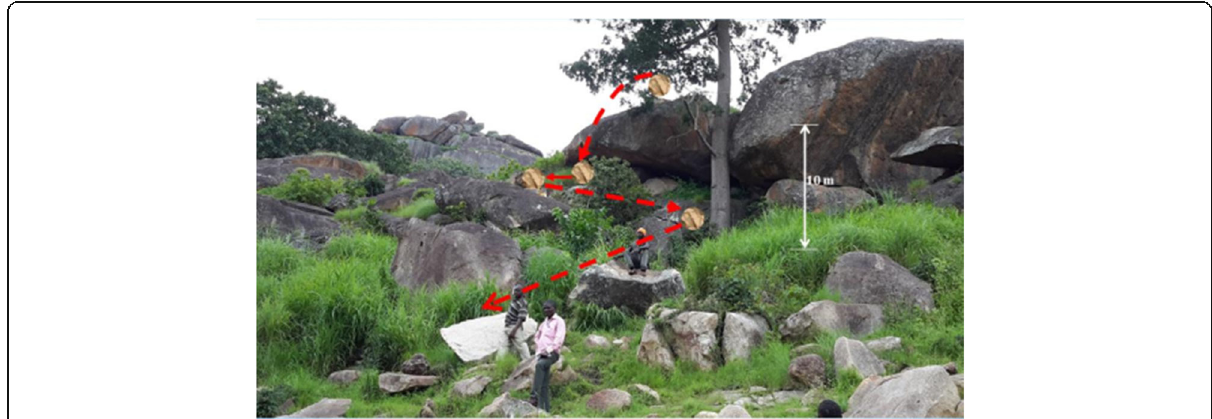
Fig. 5 Reconstructed field sketch of the displaced rock fragments as a result of the tremor. The rock boulder rolled over a cumulative distance of ver 15 m and spilt into two on landing. The movement path is indicated in red